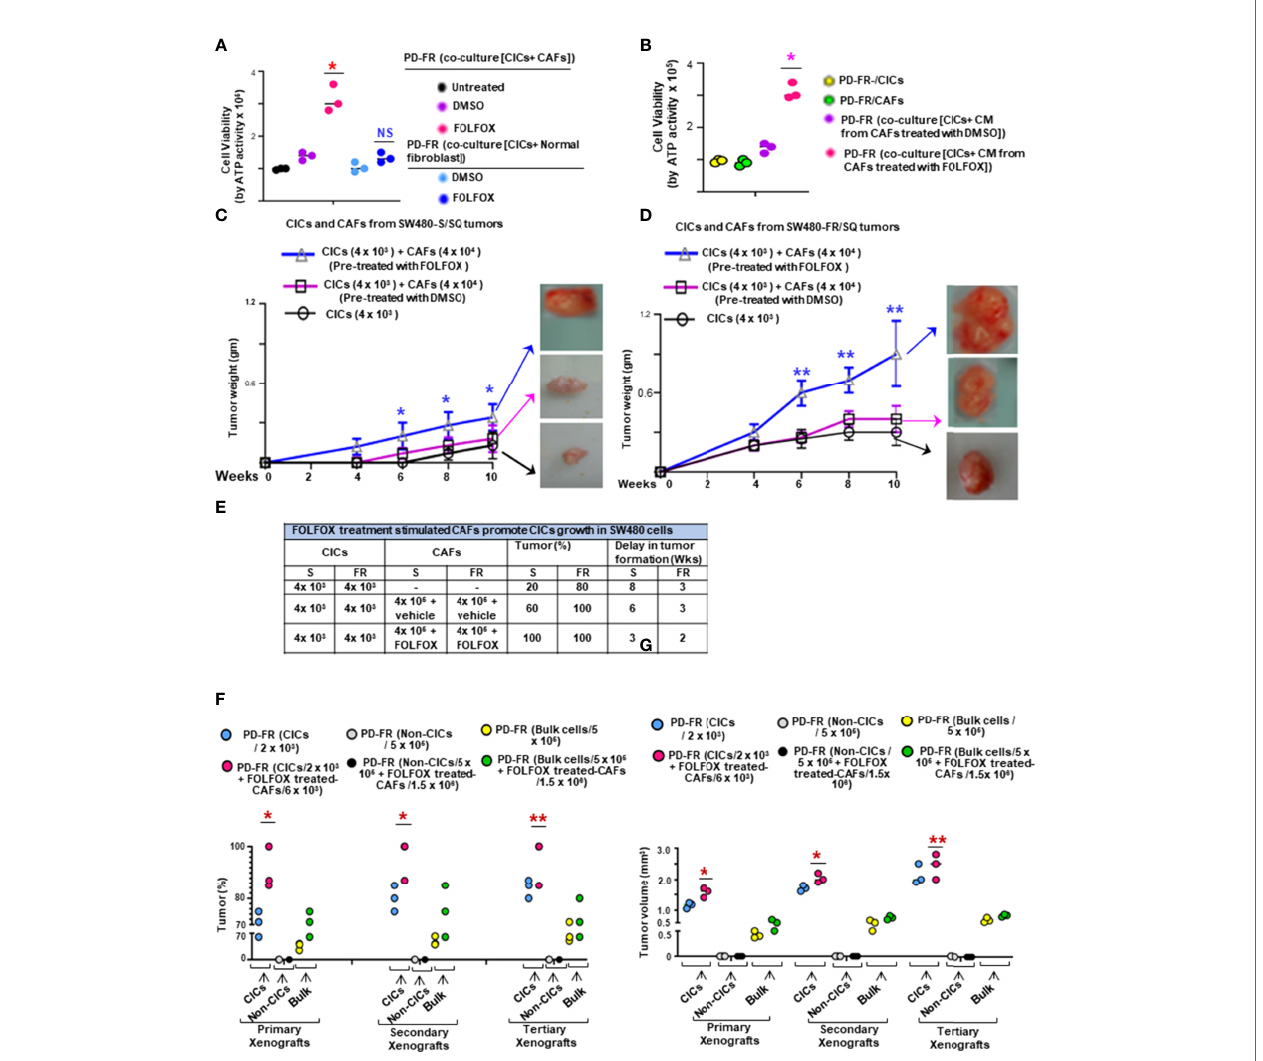
FIGURE 3 | FOLFOX-stimulated CAFs promote CIC growth. (A, B), The effect of CAFs on CICs was measured by co-culture of PD-FR/CICs with PD-FR/CAFs (A) and conditioned media (CM) treatment (B) . (A) , 1.5 x 105 PD-FR CICs were cultured with 3 x 105 PD-FR CAFs or with 3 x 105 normal fi broblasts pre-treated with vehicle (DMSO) or with FOLFOX-therapy for 12 days. Cellular viability was measured by the ATP Glo assay. (B) , 1.5 x 105 PD-FR/CICs, and 3 x 105 PD-FR CAFs were treated with vehicle (DMSO) or with FOLFOX for 72 hours. Conditioned media (CM) from CAFs were collected and used to culture CICs for 12 days. Cellular viability was measured by the ATP Glo assay. (C, D) , The abilities of the CAFs (4 x 104 ) to affect the tumor growth of CICs (4 x 103 ) from three different batches of SW480-S. (C) and of SW480-FR (D) were tested for tumorigenic potential. SW480-FR/SQ CAFs that were pre-treated with vehicle (DMSO) or with FOLFOX for 72 hours were subcutaneously co-implanted in immunocompromised mice. Tumors were harvested every week to evaluate their latency, and weights were measured to evaluate their development. (E) , The contributions of SW480-S/CAFs and SW480-FR/CAFs to post-FOLFOX treated tumor growth (tumor %) in their CICs were assessed by measuring tumor 10 weeks after implantation of the CICs and CAFs into immunocompromised mice. (F) , Numbers of SQ tumors formed by injections of the indicated numbers of CICs, Non-CICs, and unfractionated bulk tumor cells with and without addition of FOLFOX treated CAFs from the PD-FR cells are shown. FACS sorted CICs (2 x 103), Non-CICs (5 x 105), and the unfractionated bulk tumor cells (5 x 105), with and without FOLFOX treated CAFs (6 x 103 or 1.5 x 106 cells) from PD-FR tumor cells were resuspended in Matrigel and implanted in immunocompromised mice. The same cells from the fi rst generation of SQ tumors were further implanted into immunocompromised mice to generate second generation of xenograft tumors. The experiments were repeated to generate tumors into a third generation of xenograft tumors. Only CICs and the unfractionated bulk tumor cells were capable of inducing fi rst generation xenograft tumors formations. Isolation of second and third generation xenograft tumors displayed similar results (n = 5 analyzed patients derived cells, 8 mice group and experiments were performed in triplicates), Tumor percent (percentage of tumor bearing mice) (F) and tumor volumes (G) from experiment (F) were evaluated. Data are presented as Mean ± SD from n = 5 analyzed patients derived cells, 8 mice/group and experiments independent replicates in three independent experiments. (A, B) , *, P < 0.05 was considered signi fi cant, percent cell viability with FOLFOX treatment compared with DMSO treated coculture after normalization to that of untreated coculture. Student ’ s t-test was used to assess the signi fi cance. (C, D) , Tumor growth stimulation data with pre-treatment with FOLFOX compared with DMSO-treated CICs + CAFs after normalization to tumor growth of CICs represent means ± SD.; n = 5-8; *, P < 0.05. **, P < 0.01 were considered signi fi cant; (F, G) , Tumor (%) and tumor volume of primary, or secondary, and tertiary xenografts from CICs-tumor compared to Bulk-tumor populations. *, P < 0.05, **, P < 0.01 were considered signi fi cant; ANOVA, followed by Bonferroni ’ s post-hoc test was used to assess the signi fi cance in experiments (C,